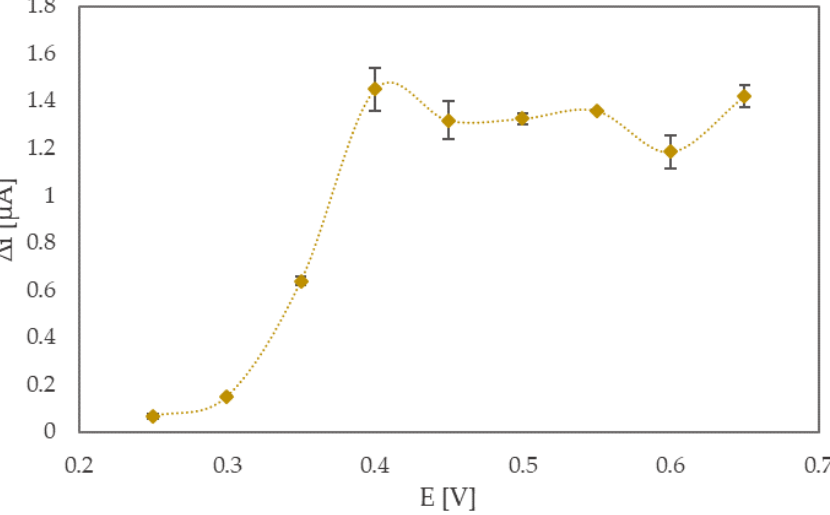
Figure 2. Sensor response towards 0.2 mM glucose in 0.1 M phosphate buffer (pH 7.4) measured at different operating potentials. The line was smoothed with Microsoft Excel.